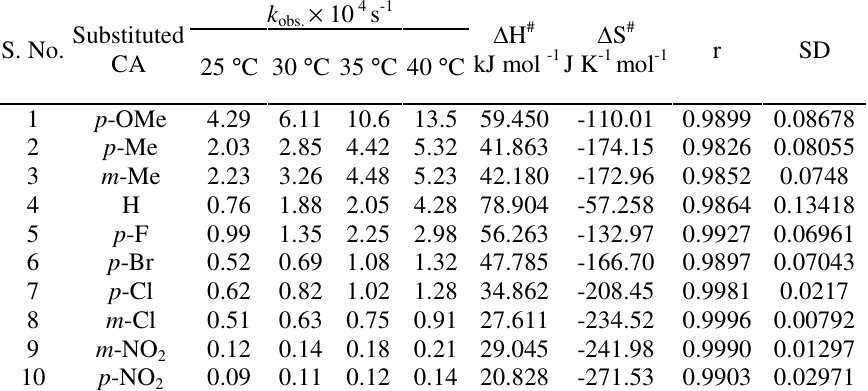
Table 5. Thermodynamic parameters of substituted trans -cinnamic acid.